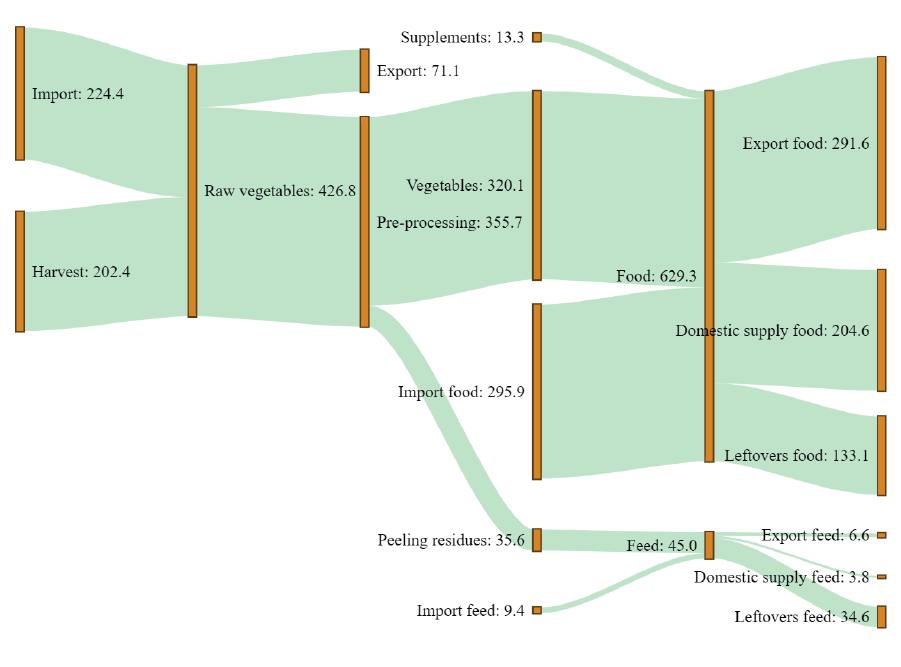
Fig. 7. Sankey diagram for bioresource flows of base scenario in 2030 for vegetables, thousand